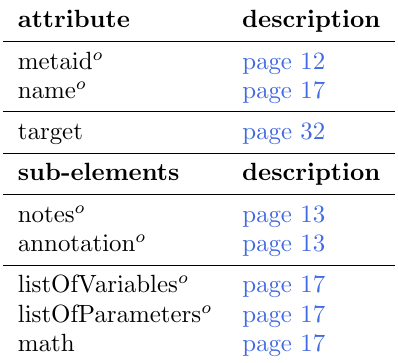
Table 2.12: Attributes and nested elements for computeChange. o denotes optional elements and